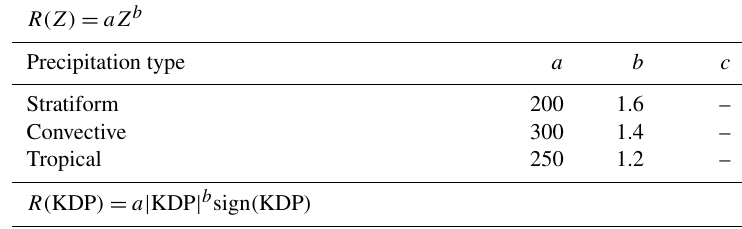
Table 2. List of single- and dual-polarimetric algorithms used for radar rainfall